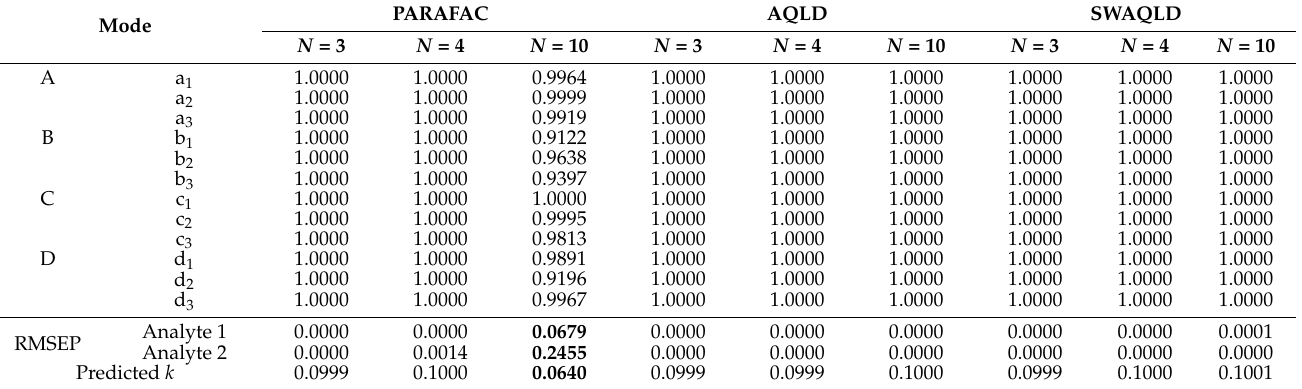
Table 5. The influence of factor numbers ( N ) on correlation coefficients, RMSEPs, and k values predicted by PARAFAC, AQLD, and SWAQLD, respectively, for simulated four-way data with α homo =